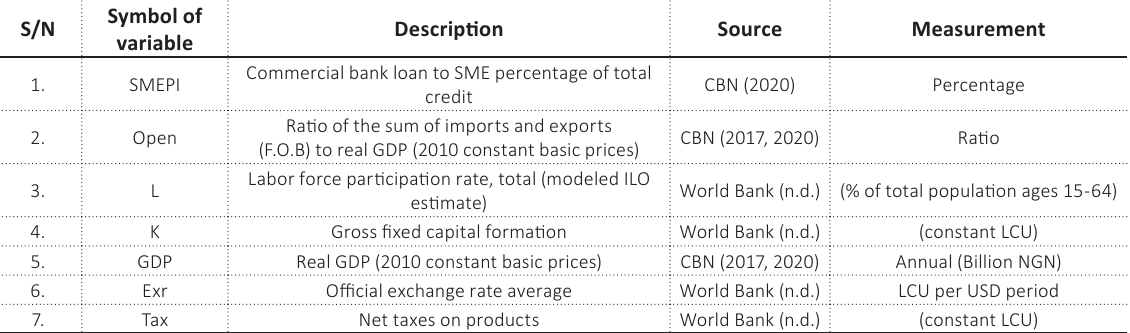
Table 1. Variable description, source, and